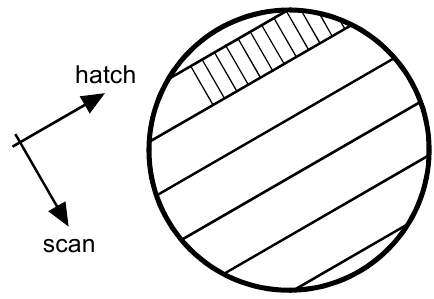
Figure 1. Scheme of the directions of the laser beam in scanning and hatching over a surface.